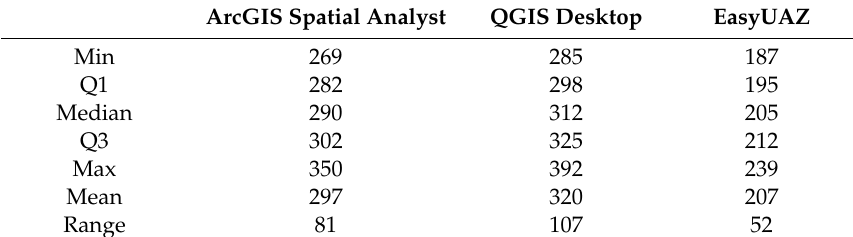
Table 4. The statistical distribution of task completion time (in minutes).